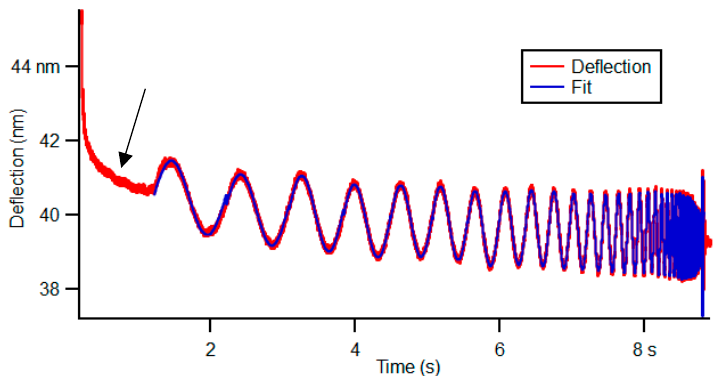
Figure 2. A representative of the deflection signal versus time during dwell, i.e., while the tip is in contact for 8.7 s, during frequency sweep. The first region of red curve (identified by the black arrow) presents the sample creep after loading the cell during the approach. This stress relaxation of the cell was not analyzed. The analysis of the curve starts with the curve fitting (blue color).